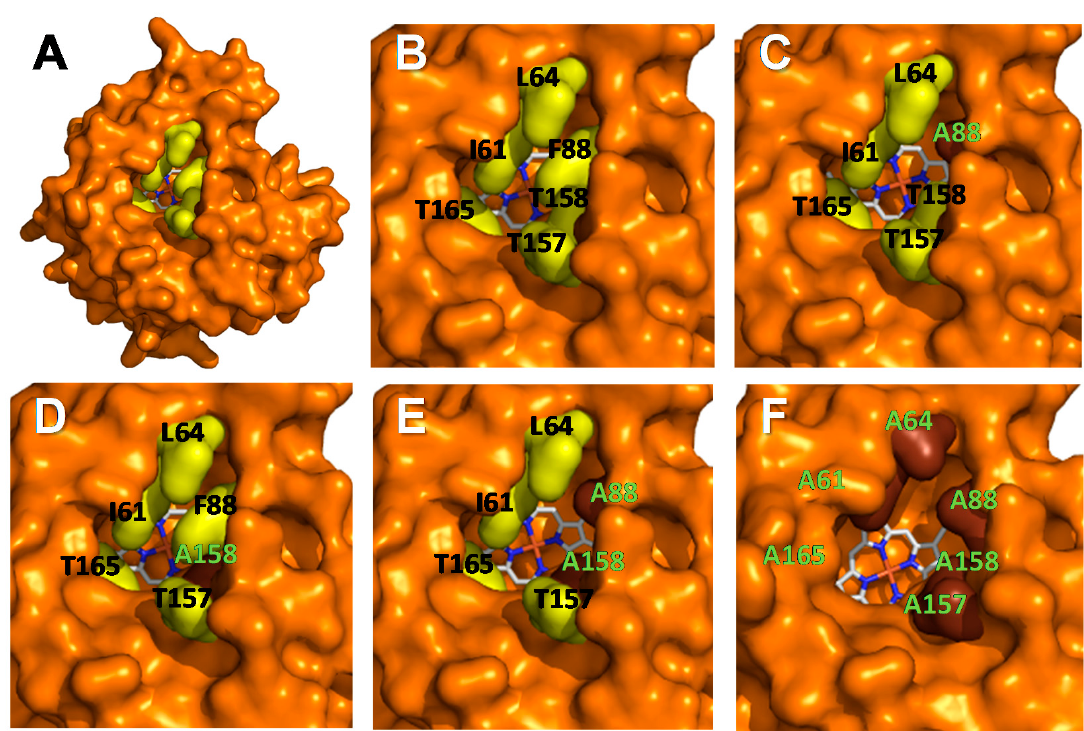
Figure 2. Solvent-access surface in Cvi UPO molecular model ( A ), and detail of the access channel to the heme cofactor (as CPK-colored sticks) in the native enzyme ( B ) and its F88A ( C ), T158A ( D ), F88A/T158A ( E ), and 6Ala ( F ) variants. Those residues to be mutated (black labels) have yellow surfaces; the already-introduced alanines (yellow labels in C – F ) show brown surfaces.